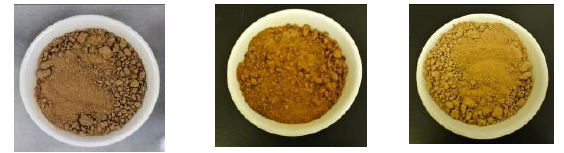
Figure 14. Soil tests(left: naturally dry; middle: mixed with deionized water; right: absolutely dry)